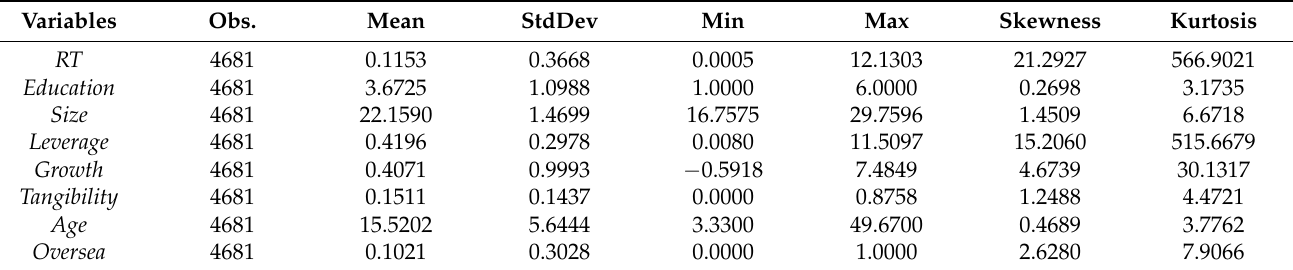
Table 1. Summary Statistics.